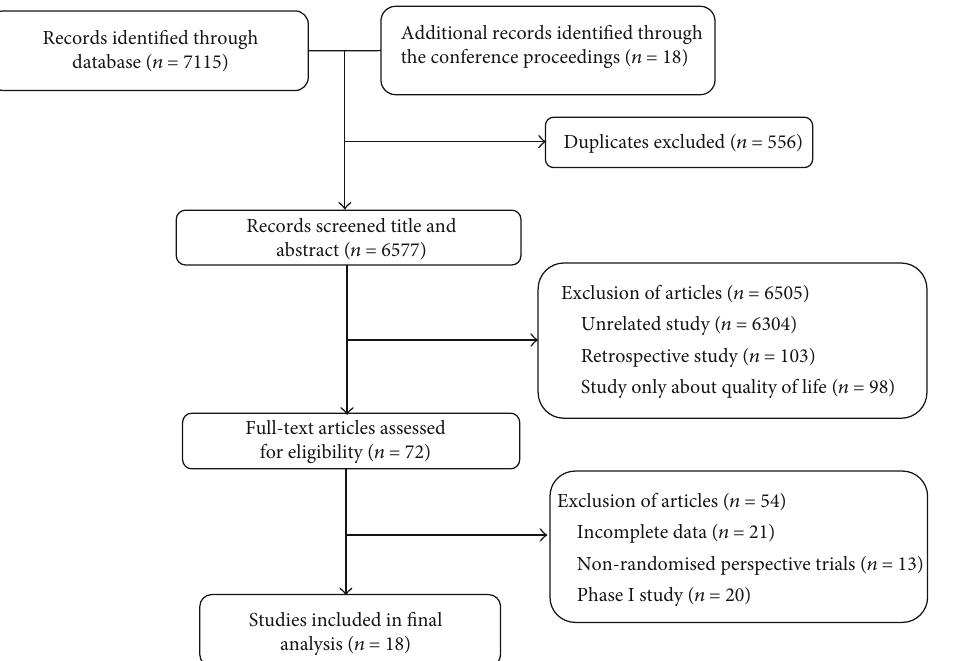
Figure 1: Flowchart diagram of the selection process for the